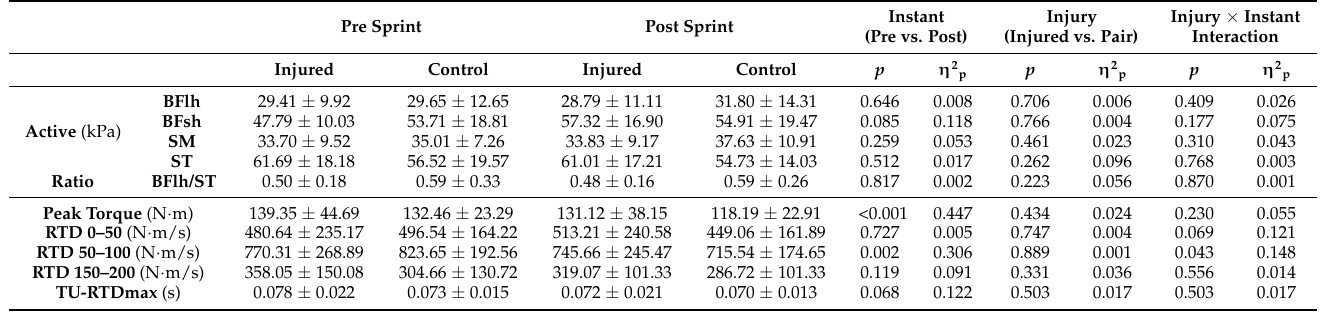
× Instant Interaction